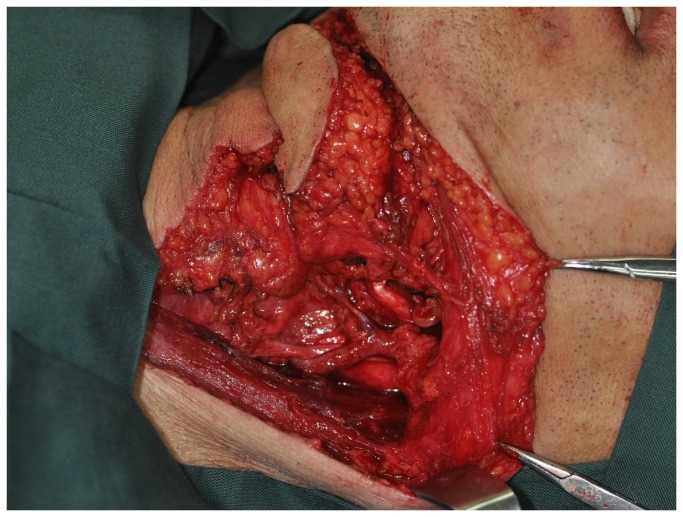
The flap is raised.